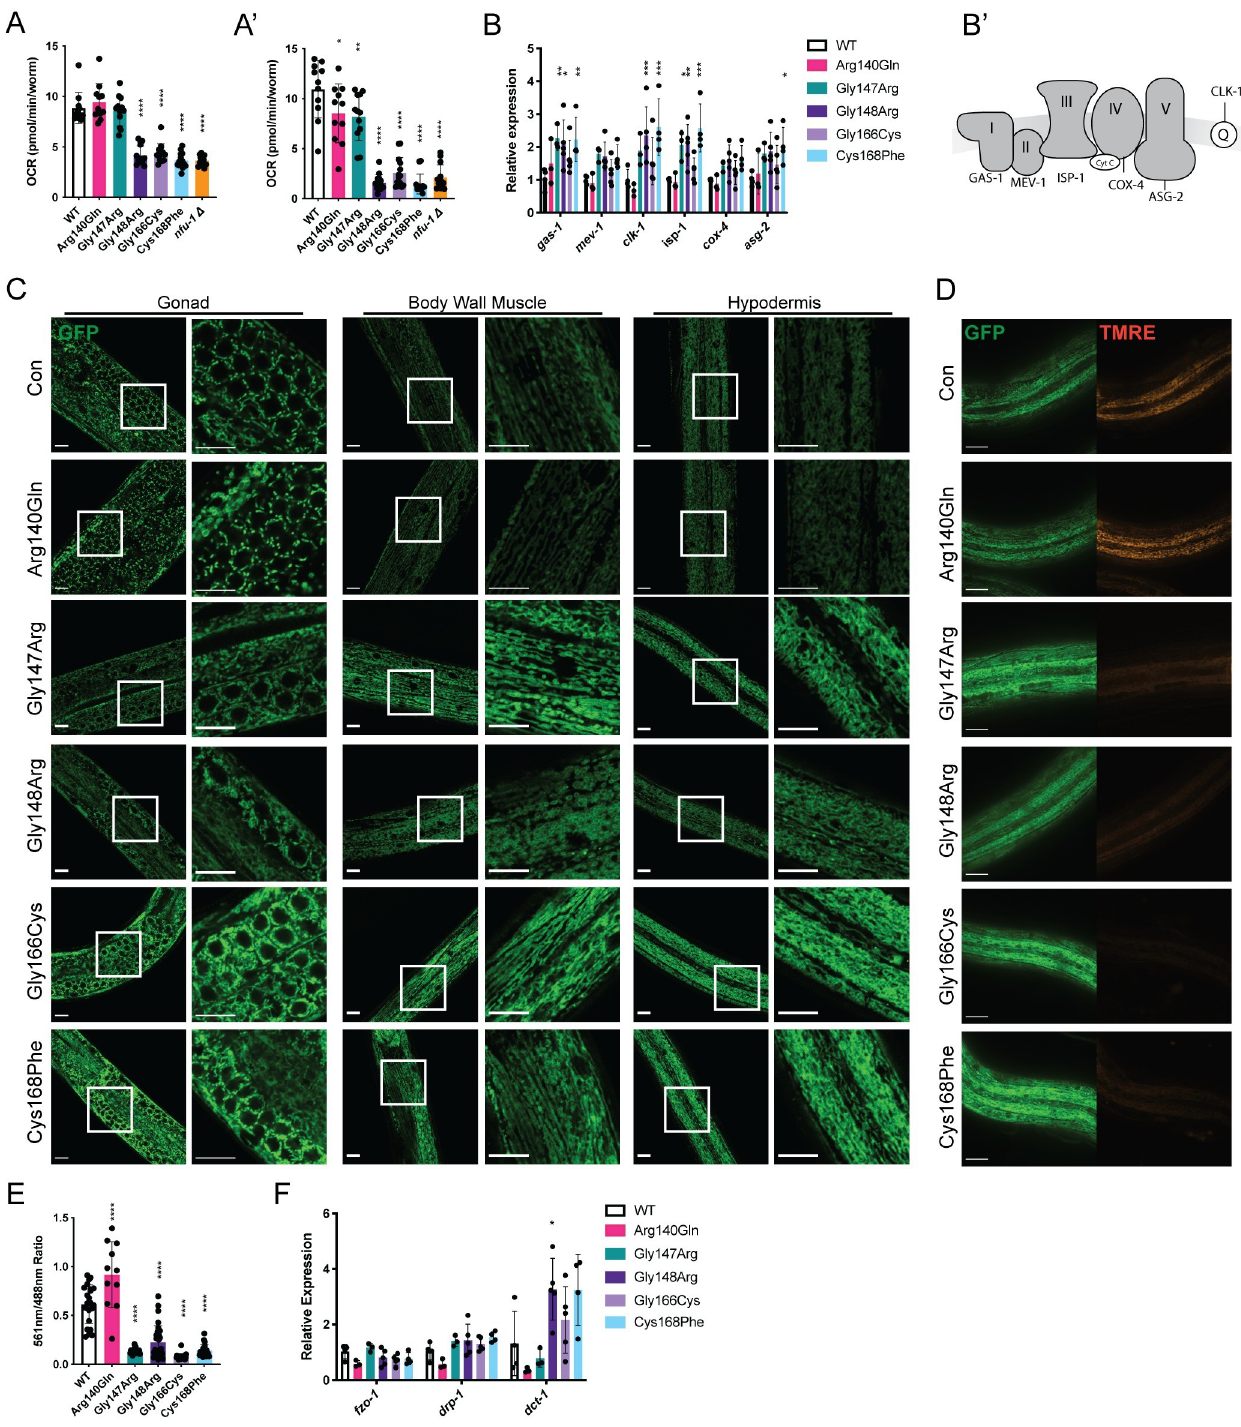
Fig 3. Mitochondrial physiology and function are impaired by nfu-1 mutations. (A-A’) OCR as measured via Seahorse XFe96 (n = 11–14). (A) Basal OCR. (A’) Maximal OCR. (B) Gene expression of ETC components and accessory factors (n = 3–5). Genes assessed in order presented: gas-1 (CI), mev-1 (CII), clk-1 (Coenzyme Q), isp-1 (CIII), cox-4 (CIV), and asg-2 (CV). (B’) ETC schematic with the factor measured in (B) indicated for each complex or accessory factor. (C) Representative COX-4::GFP expression in mitochondria of WT and nfu-1 mutants in the gonad, body wall muscle, and hypodermis. Images captured at 63X or 63X + 3X digital zoom. White boxes indicate regions enhanced at right. Green: COX-4::GFP. Scale bar: 10 μ m. (D) TMRE labeling of hypodermal mitochondria in WT and nfu-1 mutants. Green: COX-4::GFP; Red: TMRE. Scale bar: 20 μ m. (E) Quantification of (D). Ratiometric measure